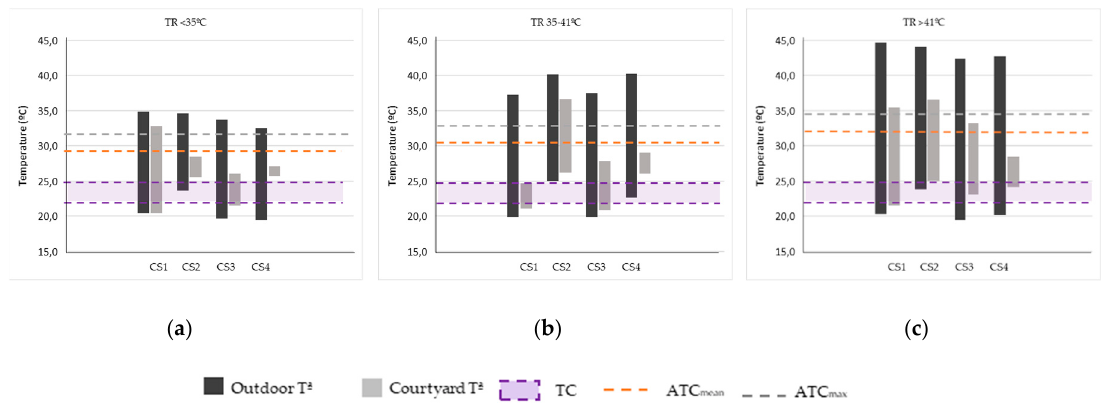
Figure 3. Outdoor versus courtyard DTR. ( a ) TR < 35 °C; ( b ) TR 35–41 °C; ( c ) TR > 41